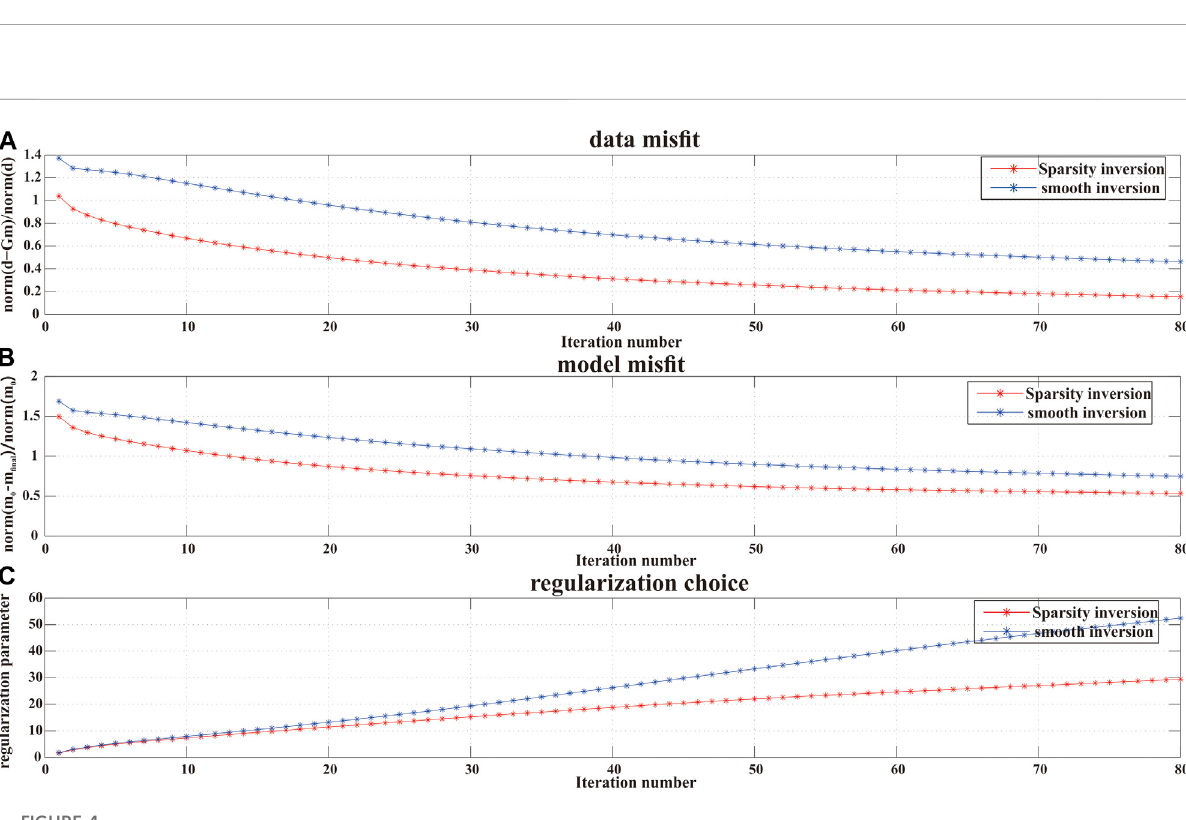
FIGURE 4 Comparison between thesparsityinversion and thesmooth inversion. (A) Progression ofthedatamis fi t:sparsity inversion inred -*andsmooth inversion in blue -*; (B) Model mis fi t; (C) Regularization choice of each